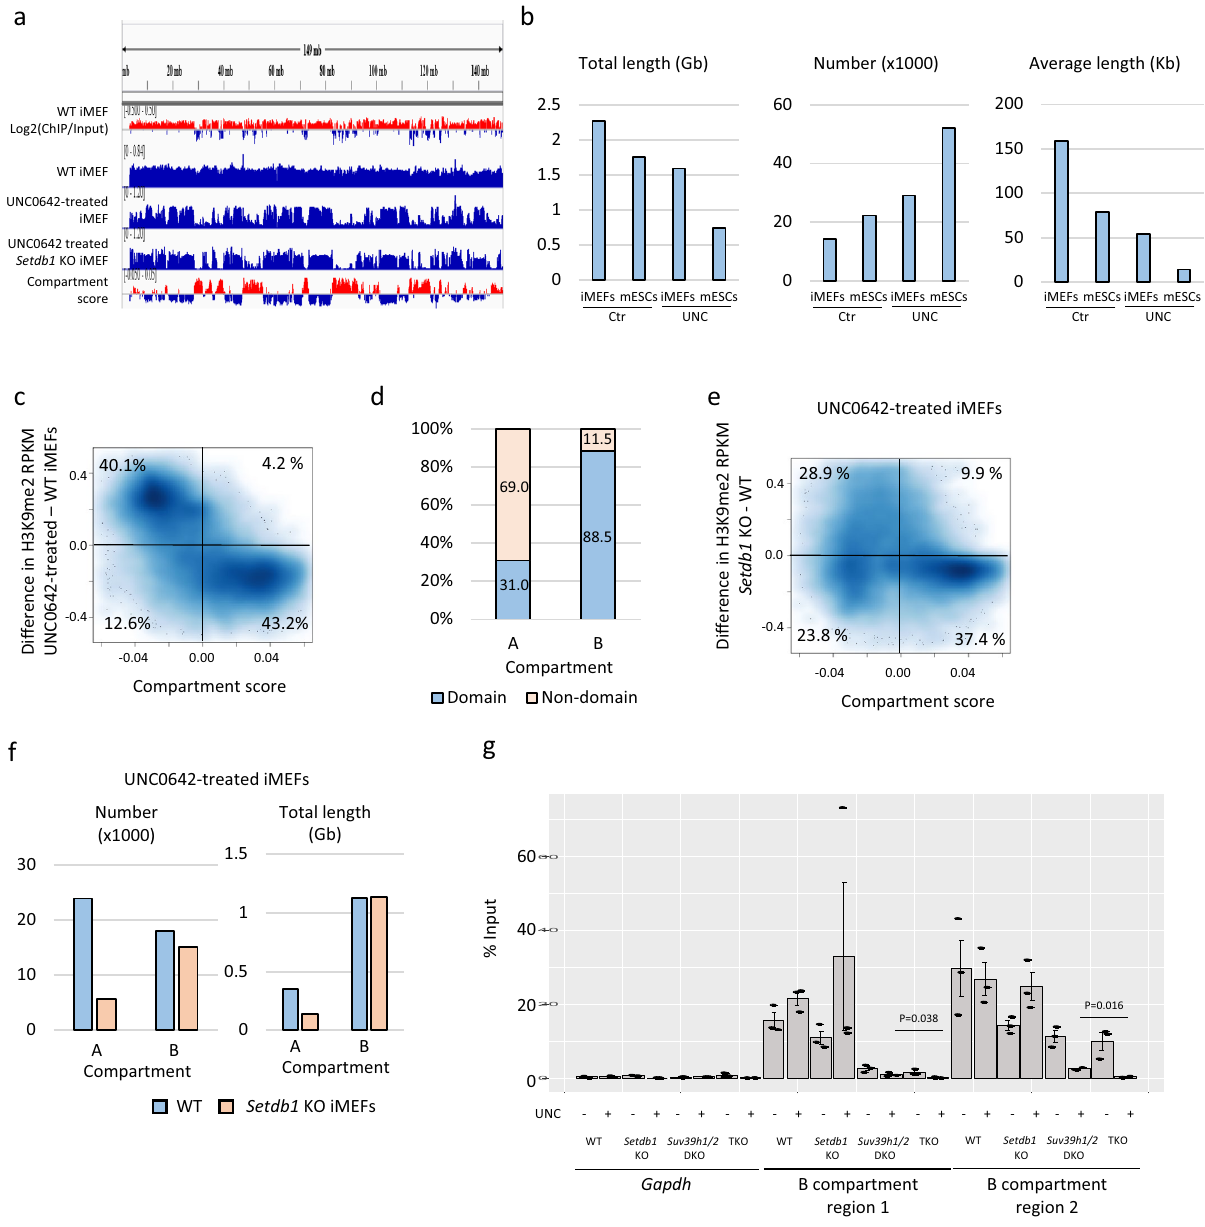
Fig. 2 Characterization of SETDB1- and SUV39H1/2-dependent H3K9me2 regions in iMEFs. a Representative view of H3K9me2 ChIP-seq data along chromosome 6 in iMEFs. Although H3K9me2 in the A compartments is decreased by UNC0642 treatment, low H3K9me2 signal is retained. Those retained H3K9me2 is further diminished in UNC0642-treated Setdb1 KO iMEFs. b Difference in G9a/GLP-independent H3K9me2 between mESCs and iMEFs. H3K9me2 domain size is larger in iMEFs than in mESCs. c A comparison between compartment score and H3K9me2 changes by UNC0642 treatment in iMEFs. Overall, H3K9me2 reduction in the A compartments is induced by the UNC0642 treatment. Each plot represents data from each 80- kb bin. Darker blue represents higher dot density. d Fractions of H3K9me2 domains in the A and B compartments in UNC0642-treated iMEFs. e A comparison between compartment score and H3K9me2 changes in UNC0642-treated Setdb1 KO iMEFs. In comparison with UNC0642-treated WT iMEFs ( c ), UNC0642-treated Setdb1 KO iMEFs showed further reduction of H3K9me2, especially in the A compartments. f The number and the length of H3K9me2 domains in WT and Setdb1 KO iMEFs treated with UNC0642. Both the number and the length of H3K9me2 domains in the A compartments are reduced in UNC0642-treated Setdb1 KO iMEFs. g H3K9me2 ChIP-qPCR analysis in regions showing in Supplementary Fig. 1o. H3K9me2 in the region 1 and 2 is completely lost in UNC0642-treated TKO iMEFs. Data are mean ± SEM; n = and SETDB1-dependent H3K9me2 than the “ middle ” and “ late ” H3K9me2 levels among genomic region classes in UNC0642- classes (Fig. 3e, f). In addition, H3K9me2 recovery after treated mESCs (see Materials and Methods). In this analysis, UNC0642 removal was not induced well in Setdb1 KO mESCs regions with similar H3K9me2 levels in WT mESCs were com- and TKO iMEFs (Supplementary Fig. 3c, d). To investigate pared. The “ early ” class showed a higher H3K9me2 level after whether H3K9me2 can spread from G9a/GLP-independent UNC0642 treatment (Fig. 3d, Supplementary Fig. 3b) and over- H3K9me2 during recovery, we analyzed H3K9me2 pro fi les lapped more frequently with G9a/GLP-independent H3K9me2